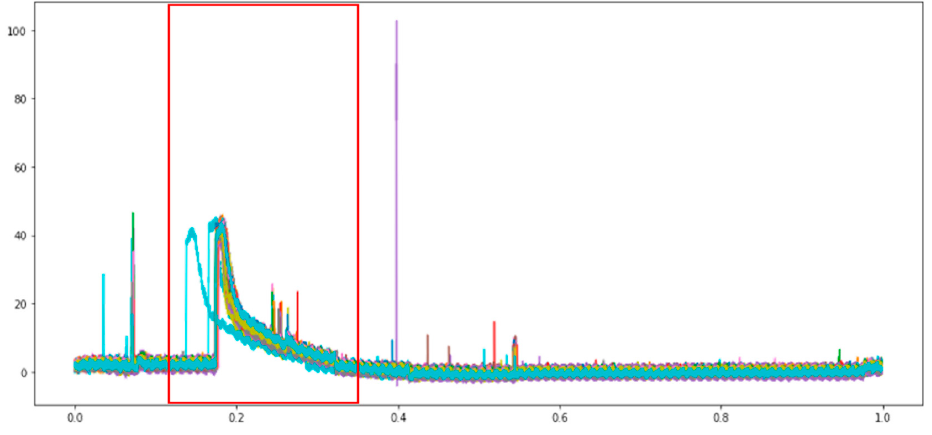
Figure 12. Feature retention range(Red frame).